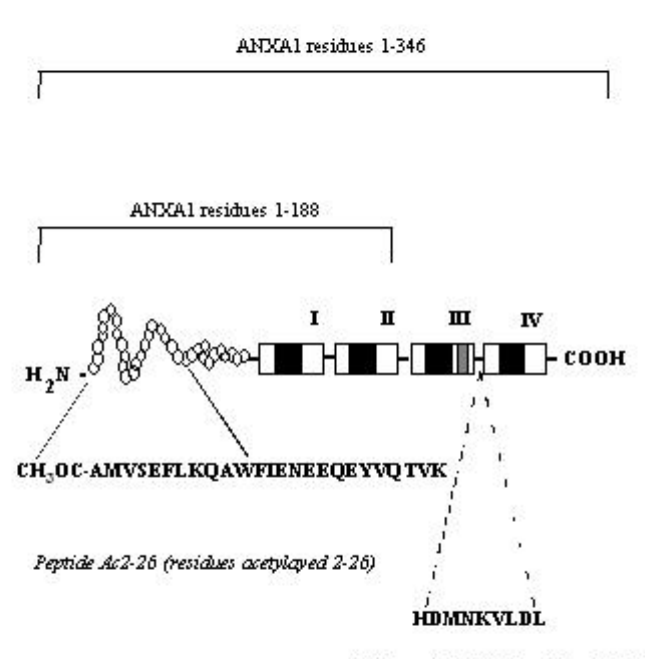
FIGURE 2. A schematic representation of annexin 1 (ANXA1) and peptides derived from the